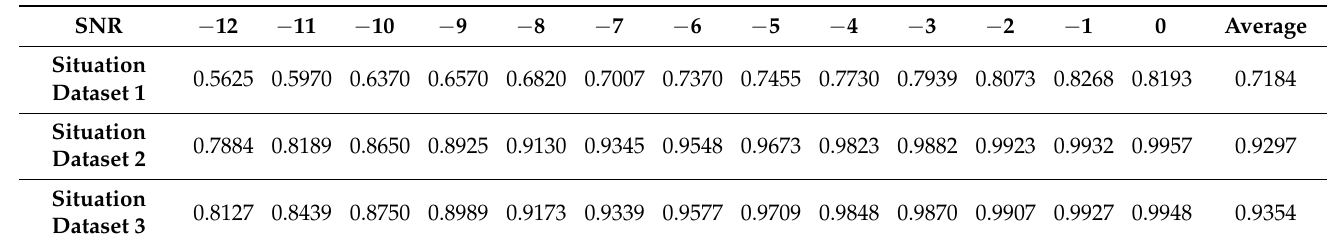
Table 4. The fully supervised classification accuracy for SNR with the datasets in Situation Dataset 1, Situation Dataset 2 and Situation Dataset 3.